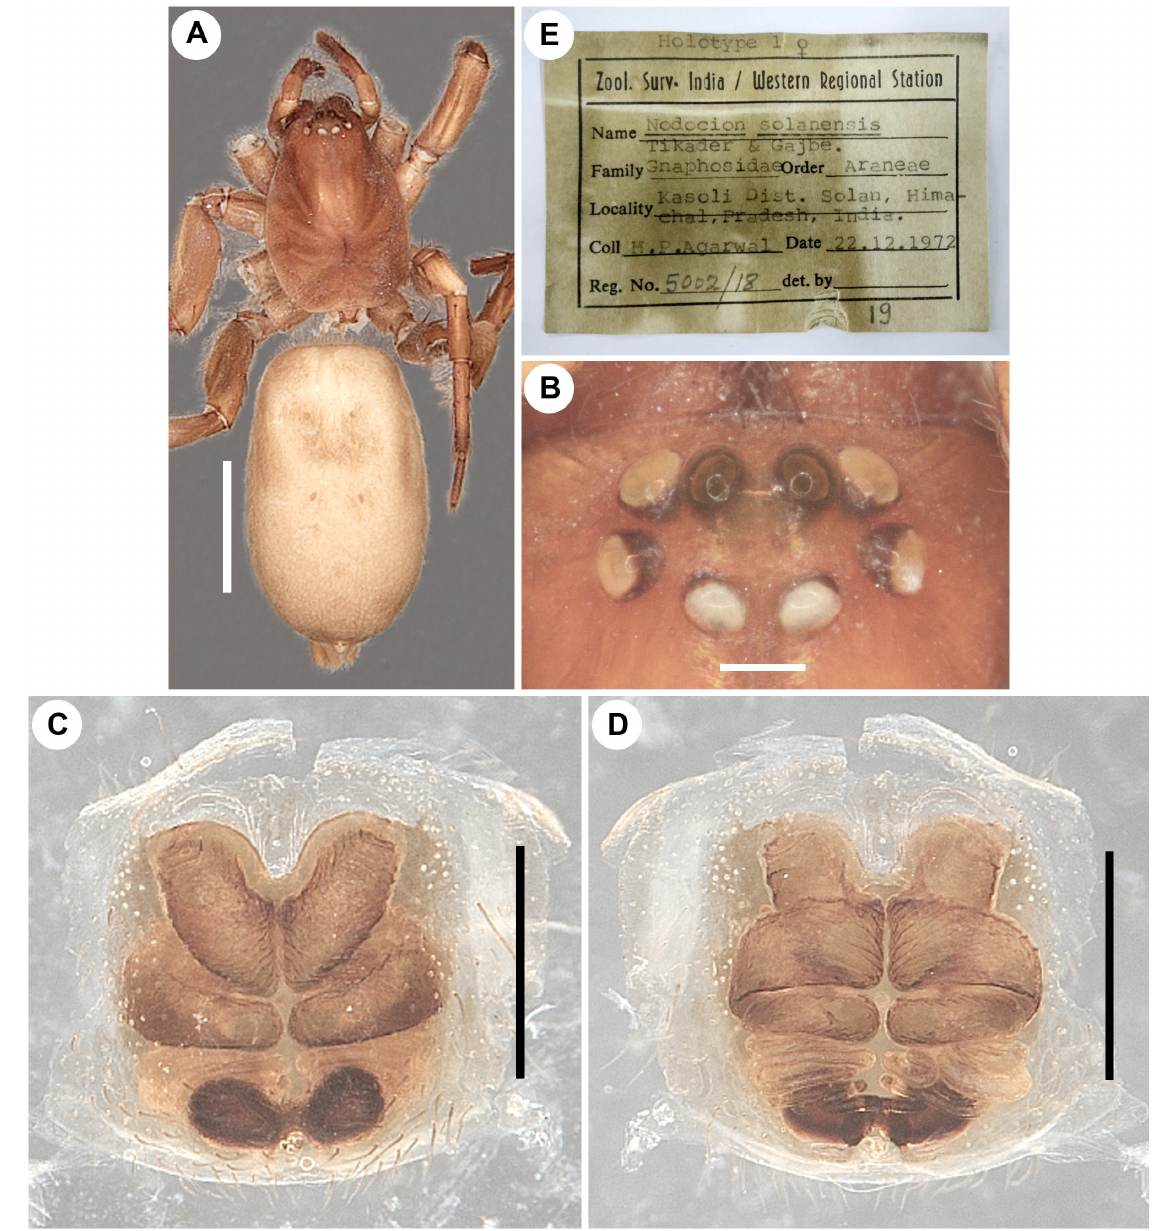
Fig. 5. “ Setaphis ” solanensis (Tikader & Gajbe, 1977) comb. nov., ♀, holotype of Nodocion solanensis Tikader & Gajbe, 1977 (NZC-ZSI-5002/18). A . Habitus, dorsal view. B . Eyes of the same, dorsal view. C . Epigyne, ventral view. D . Same, dorsal view. E . Label from type bottle. Scale bars: A = 2 mm; B = 0.2 mm; C–D = 0.5